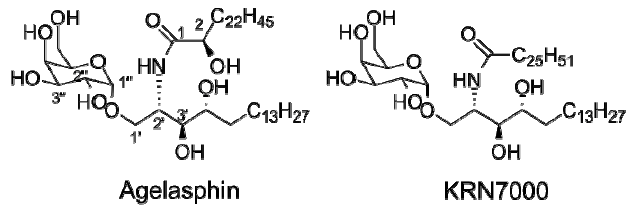
Figure 1. Representative structures of an agelasphin and